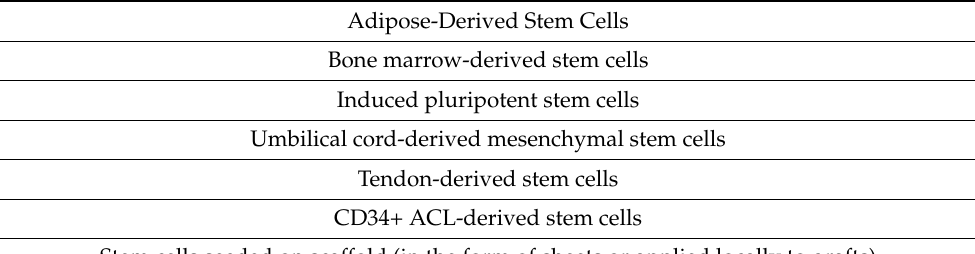
Table 2. Stem cells used in anterior cruciate ligament reconstruction.